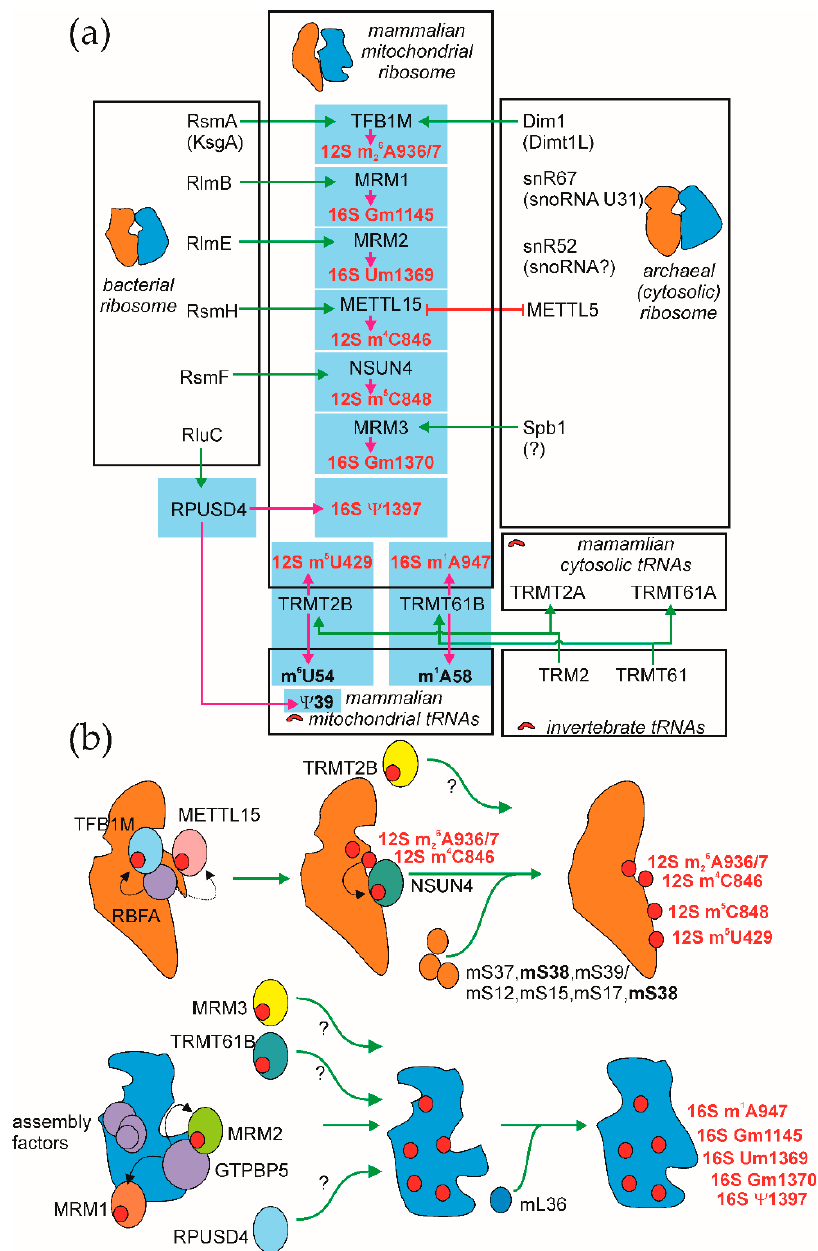
Figure 4. Mitochondrial rRNA modification in the context of evolution and mitochondrial ribosome assembly. ( a ) Likely evolutionary origin of enzymes responsible for mammalian mitochondrial rRNA modification. Boxed are the systems for the methylation of mammalian mitochondrial rRNA (center), related part of the bacterial (left) and archaeal/eukaryotic cytosolic (right) rRNA modification systems. Related systems of tRNA methylation are shown on the lower part of the panel. Pink arrows demonstrate enzymatic activities. Green arrows demonstrate possible evolutionary origin. Mutually exclusive presence of METTL15 and METTL5 is shown by a red blunt-ended arrow. ( b ) A model for the involvement of mitochondrial rRNA modification enzymes in the assembly of the small (upper part) and the large (lower part) mitochondrial ribosome subunit assembly. Orange objects corresponds to the small subunit components, while blue ones to that of the large subunit. Red circles correspond to methyl groups transferred by rRNA methyltransferases and pseudouridine formed by RPUSD4. Black arrows correspond to the stimulatory interactions; dotted arrow to the putative one.